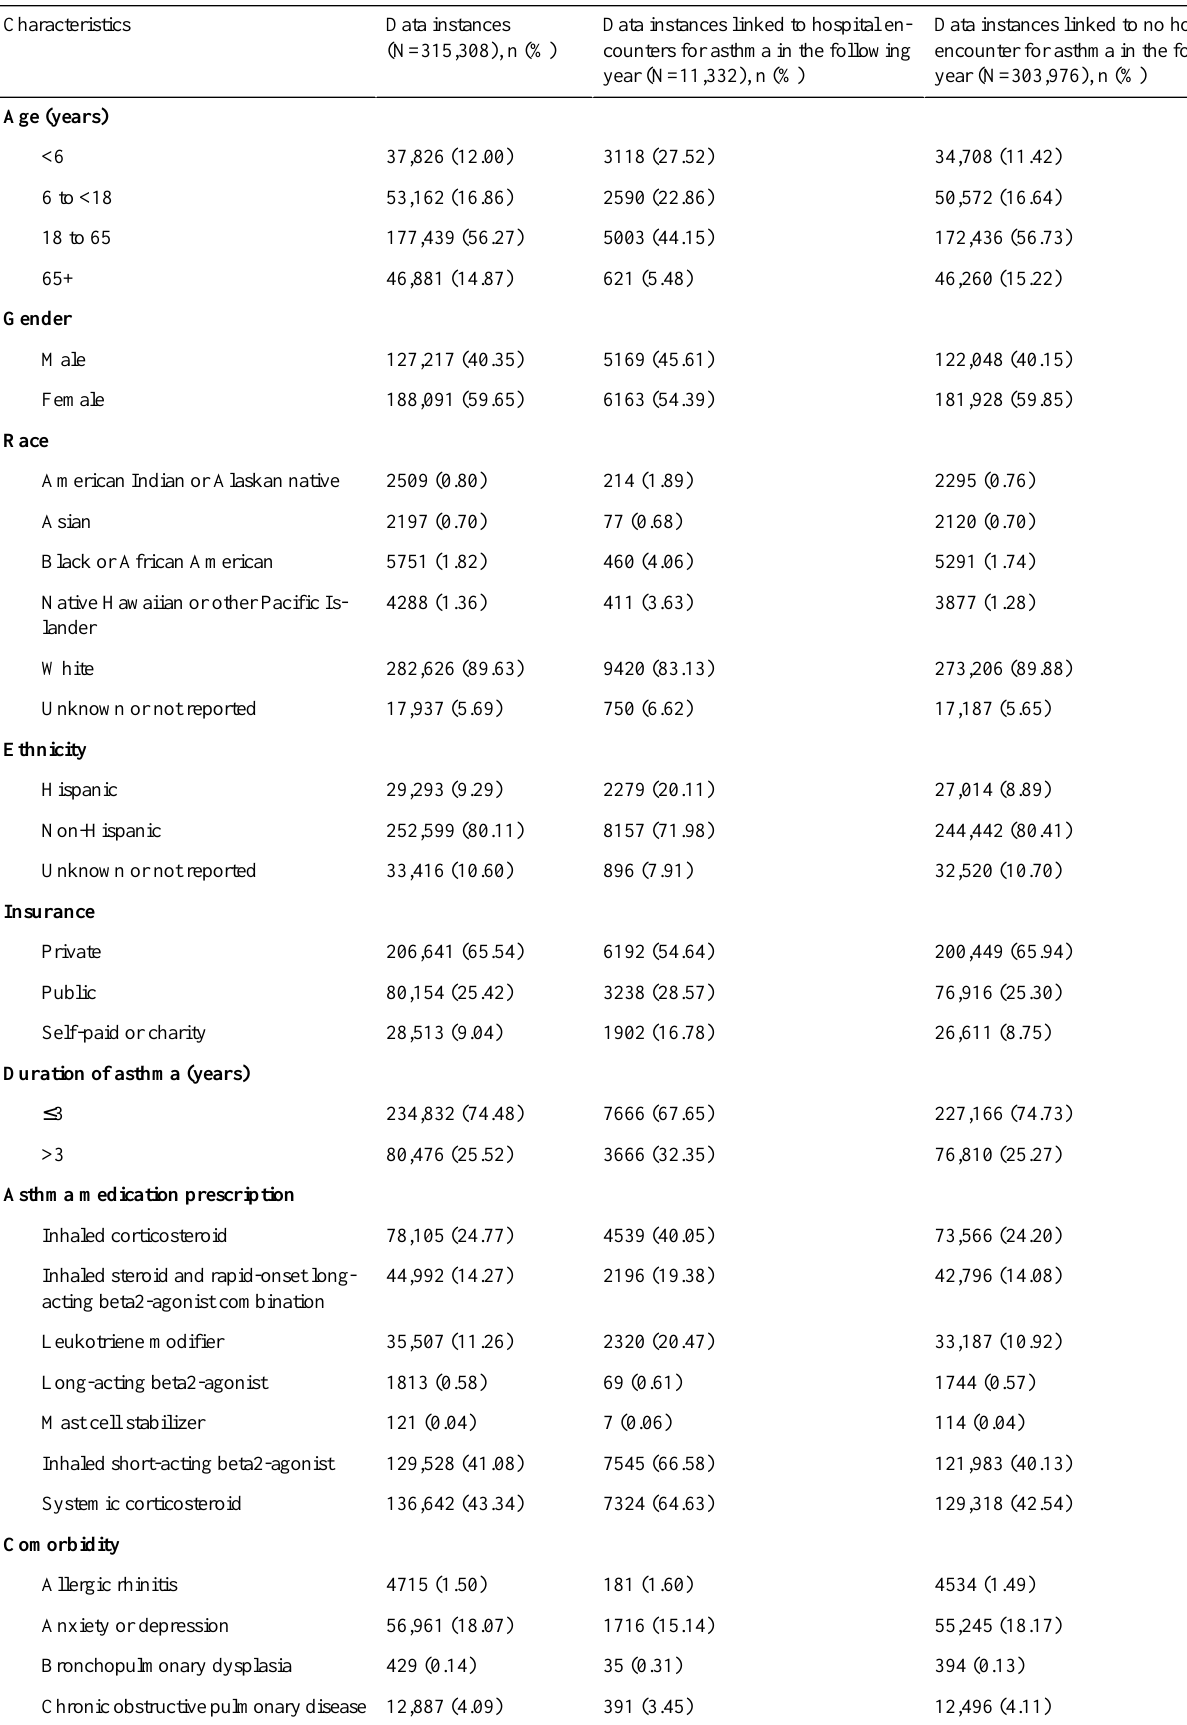
Table 2. Demographic characteristics of the asthmatic patients at Intermountain Healthcare during 2005 to